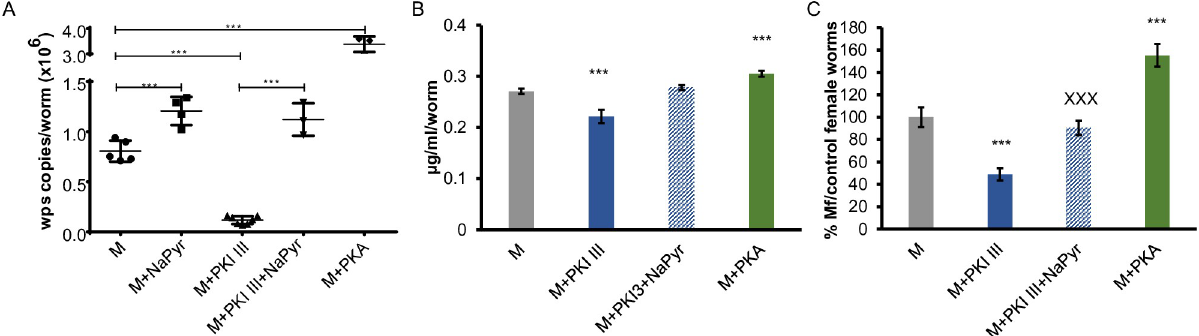
Fig 2. Effect of treatment with a pyruvate kinase inhibitor on the fitness of both Wolbachia and the worms. A. The wsp copy number per worm in adult males after a 6-day treatment was measured by qPCR ( ��� –p < 0.001). B. Relative changes in the concentration of pyruvate within the worms assigning 100% for control samples on day 1 of the treatment ( ��� –p < 0.001). C. Relative number of Mf released from female worms during the last 2 days of the 6-day treatment. Number of Mf released from control was assigned as 100%. ��� –p < 0.001 as compared to control and xxx–p < 0.001